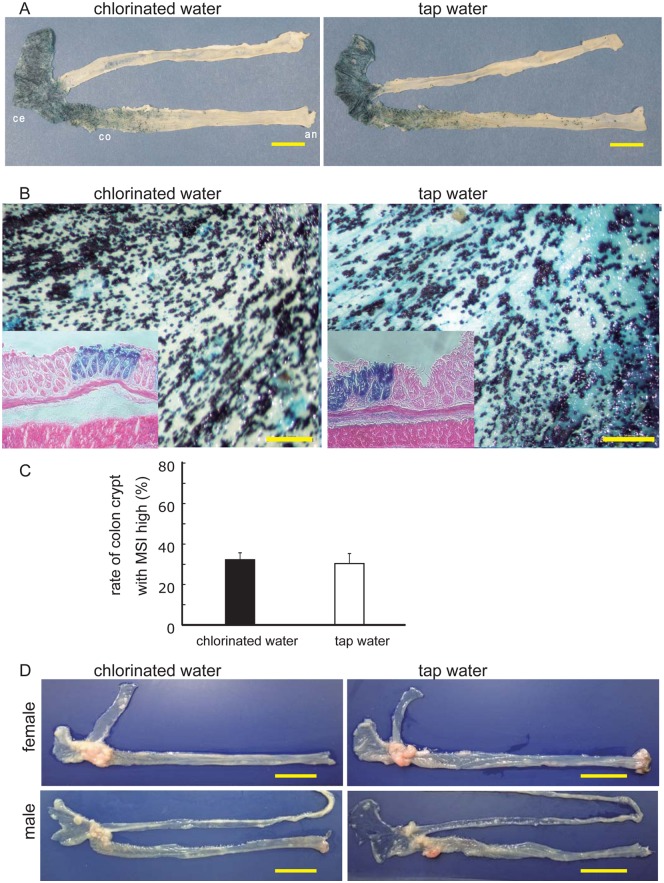
Cre activation in CDX2P9.5-G19Cre;R26R mice.
A, X-gal activity in cecal crypt in a 20-week-old CDX2P9.5-G19Cre;R26R mouse. ce, cecum; co, colon; an, anus. Bar, 10 mm. B, Stereomicrograph (45×) of the cecal epithelium (small box) with X-gal and eosin staining of a 20-week-old CDX2P9.5-G19Cre;R26R mouse. Bar, 1 mm. C, Quantitative analysis of X-gal staining in 20-week-old CDX2P9.5-G19Cre;R26R mice. Cells were counted in six fields; data represent mean ± SD. D, Dissected ileum and colorectal tract of CDX2P9.5-G22 Cre;Apc
flox/flox mice with cecum-proximal tumors. Left, tissue sample from a 15-week-old mouse treated with chlorinated water (10.0 mg/mL). Right, tissue sample from a 15-week-old mouse treated with tap water (0.7 mg/mL). Bar, 10 mm.